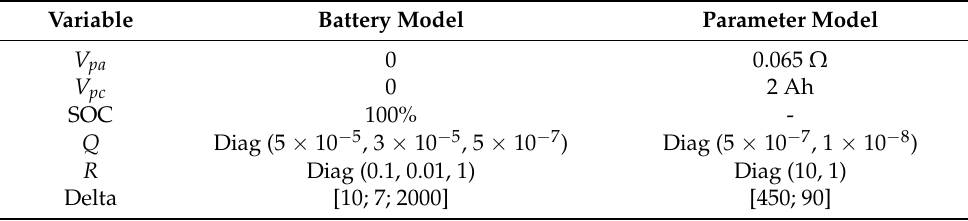
Table 3. Initialization values for both filters: Dual-KF/Dual-SIF.